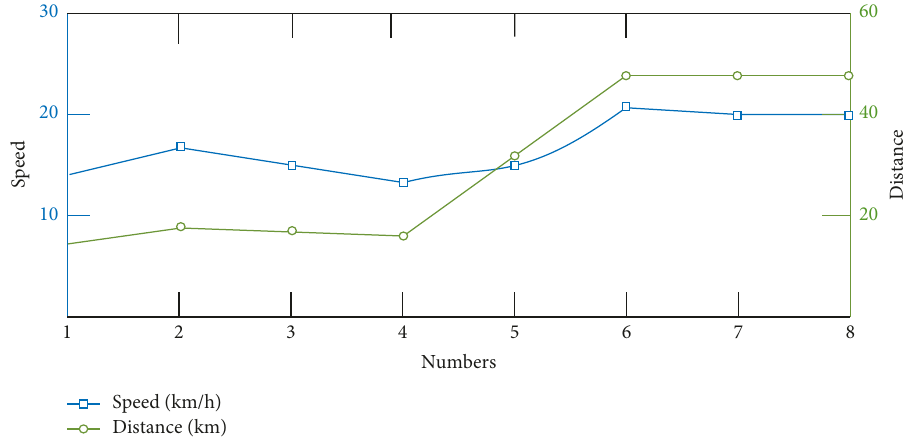
Figure 5: Relationship between distance and